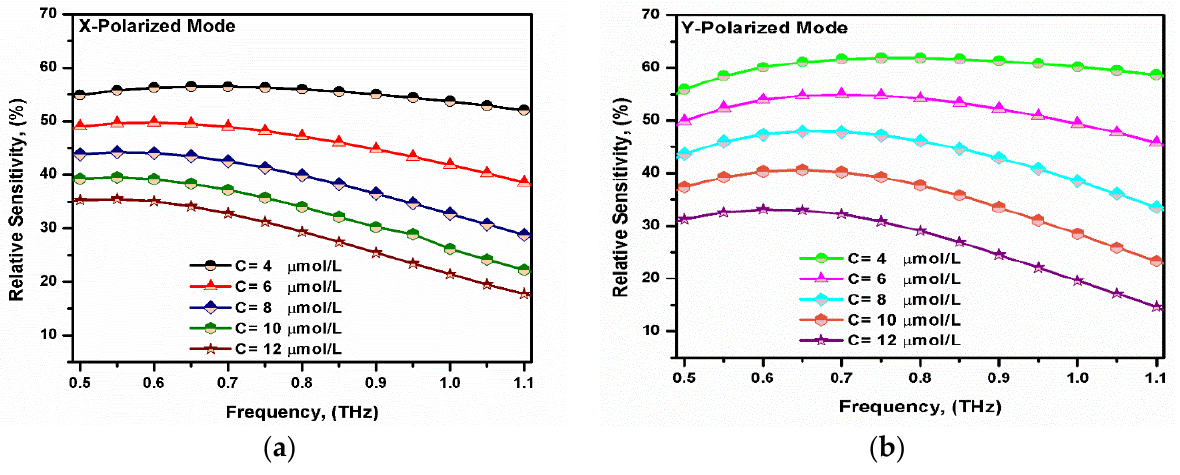
Figure 9. Variation in the relative sensitivity with the frequency for the fundamental ( a ) x-polarized mode and ( b ) y-polarized mode at different bilirubin concentrations.